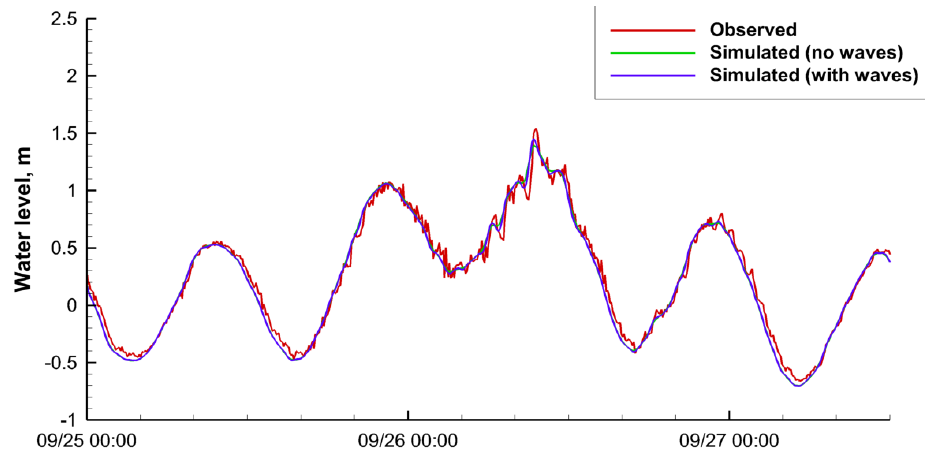
Figure 14. A comparison between simulated (hindcast) and measure waver levels at the Trident Pier Station during Hurricane Jeanne (2004).